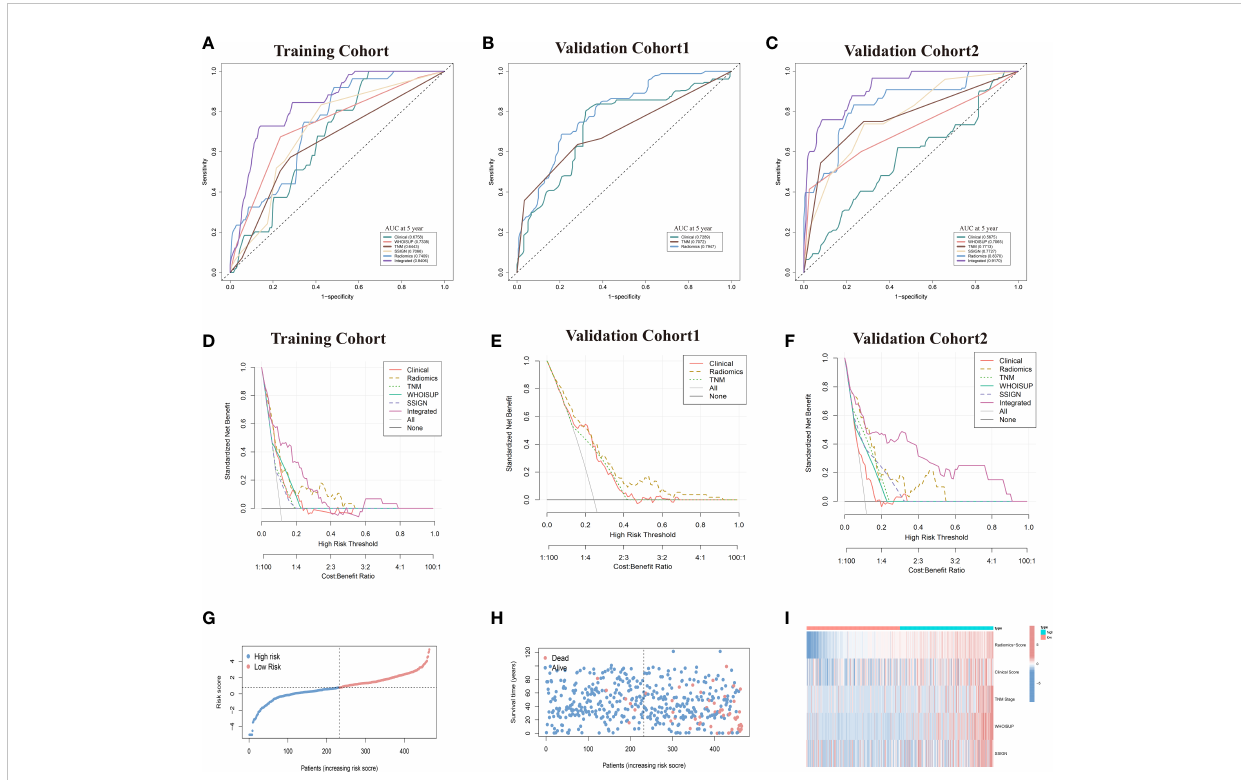
FIGURE 4 Prediction performance of the six models in the training and validation cohorts. (A – C) Time-independent ROC curves comparing the predictive accuracy of six models in the training and two validation cohorts. (D – F) Decision curves comparing six models among a series of risk thresholds in the training and two validation cohorts. (G, H) Ranked dot and scatter plots showing the radiomics-nomogram score distribution and patient survival status. (I) Component patterns of 5 selected prognostic factors in high- and low-risk groups for radiomics